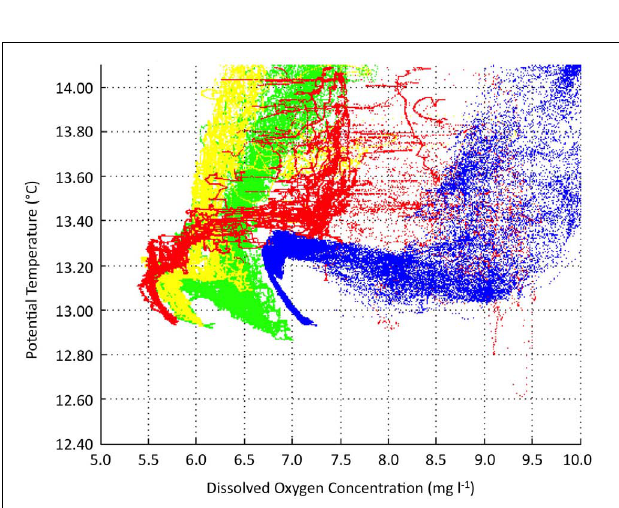
FIGURE 10 | An example of the Metadata that accompany the DM derived salinity data in SOCIB’s Data Centre.